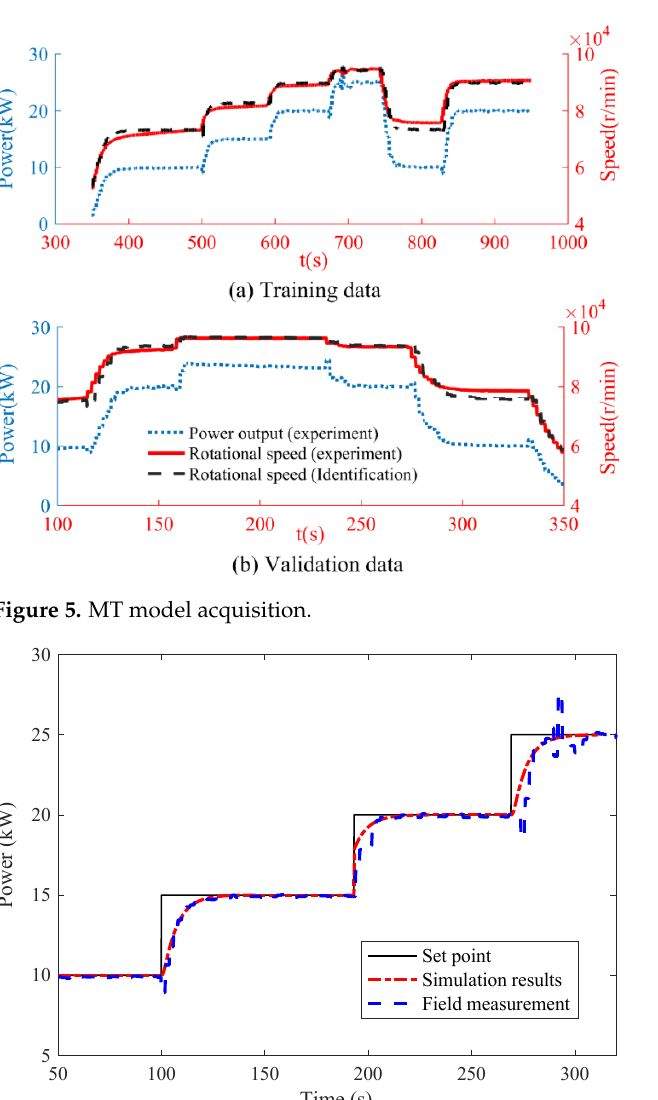
Figure 6. Comparison of MT power output simulation results and field measurement data.